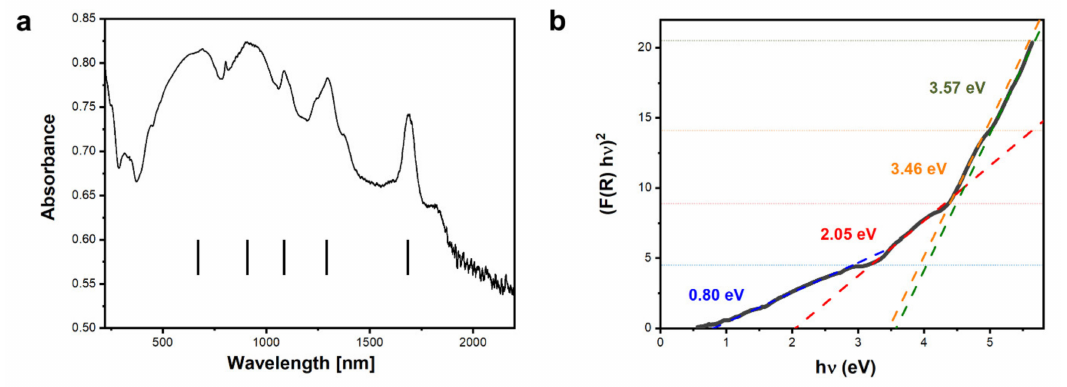
Figure 5. ( a ) UV-Vis-NIR spectroscopy measurement of the DyIG sample and ( b ) fits to the linear regions of the [ F ( R ∞ ) h ν ] 2 function, linear fits are traced with different colors for better clarity. The colors of E g values provided on the graph correspond to the colors of corresponding fitted